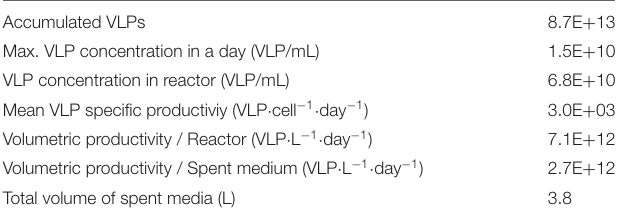
TABLE 2 | Optimized and intensified process